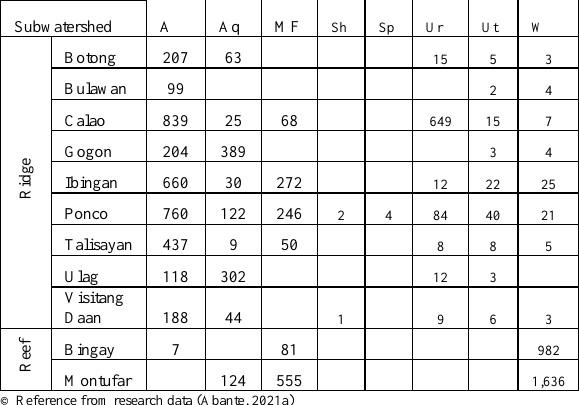
Table 2 – Sub-watershed -based Land Use Supply in Ha